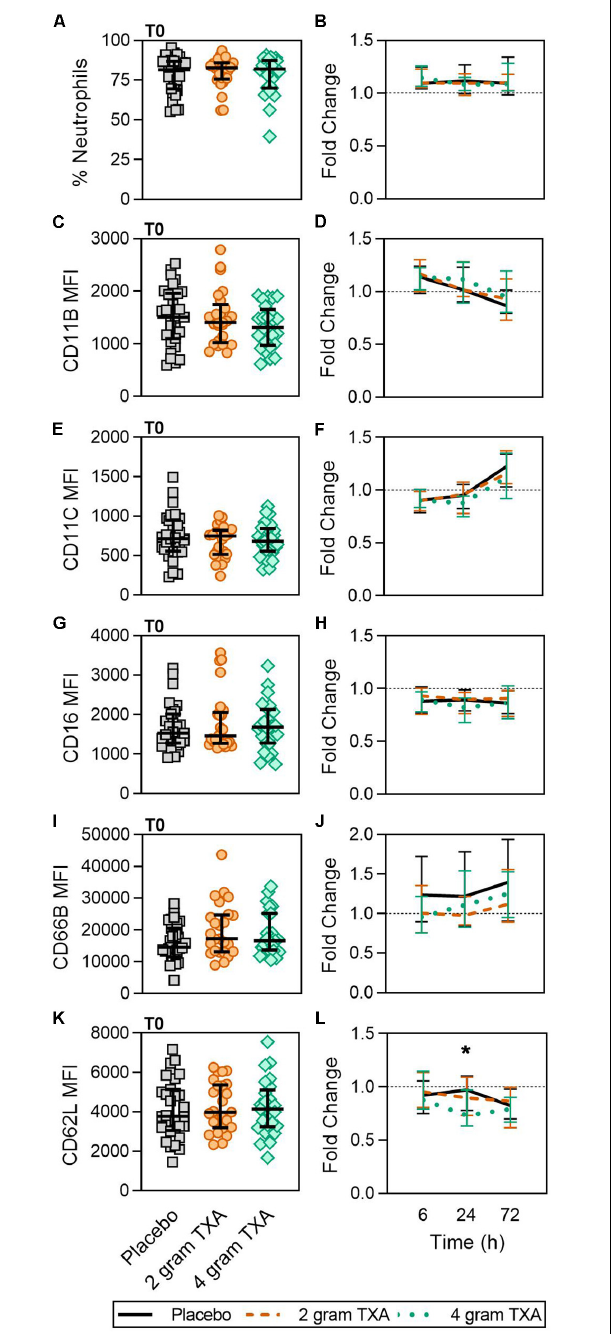
FIGURE 3 | TXA administration does not alter neutrophil frequencies or phenotype. Placebo, n = 29; 2 g TXA, n = 24; 4 g TXA, n = 25. Statistical differences between the 4 g TXA and placebo groups at each given time point, as calculated via Kruskal-Wallis, are noted as follows: p < 0.05, *; p > 0.05, not significant and not denoted on the graphical representation. (A) The frequency of neutrophils found in total peripheral blood leukocytes at T0 in all three treatment groups; data are represented as individual points with median + IQR for error bars. (B) Fold change in neutrophil frequency over the study period of 72 h. (C) CD11B MFI on neutrophils in all three treatment